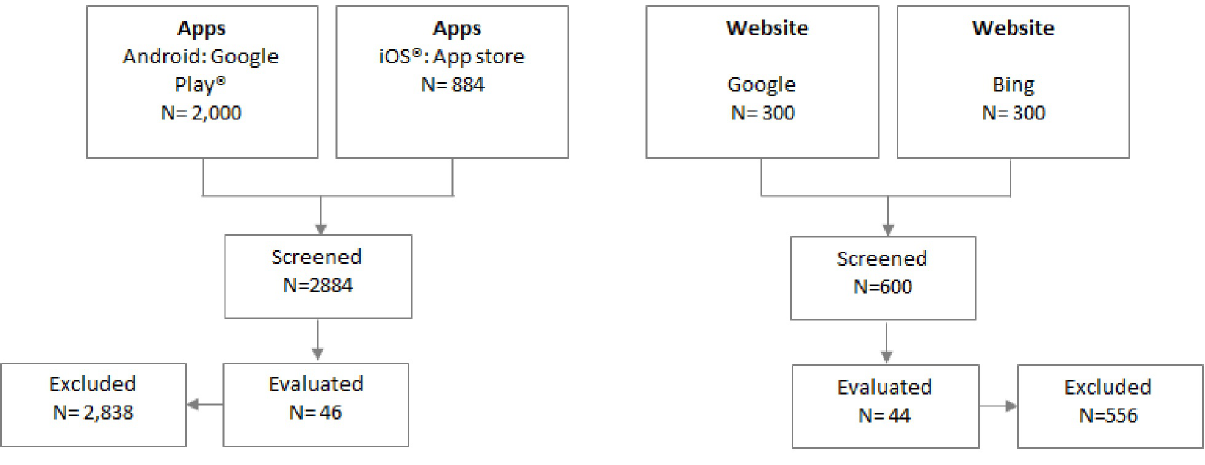
Figure 1. Flow chart of website and app